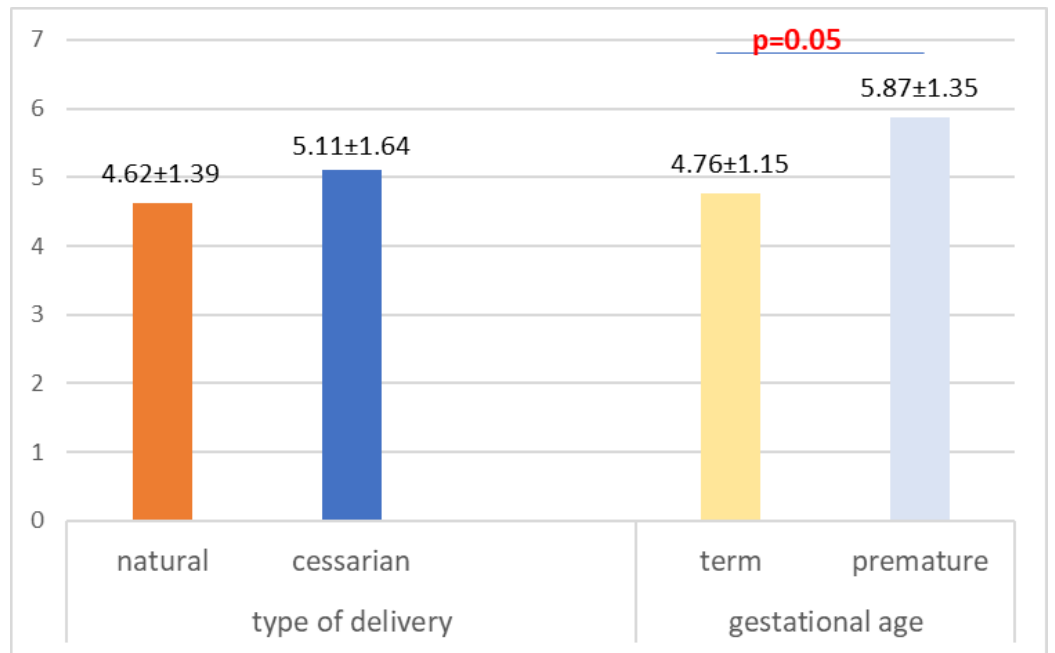
Figure 1. The intensity of pain during the vaccination procedure according to gestational age and type of delivery.